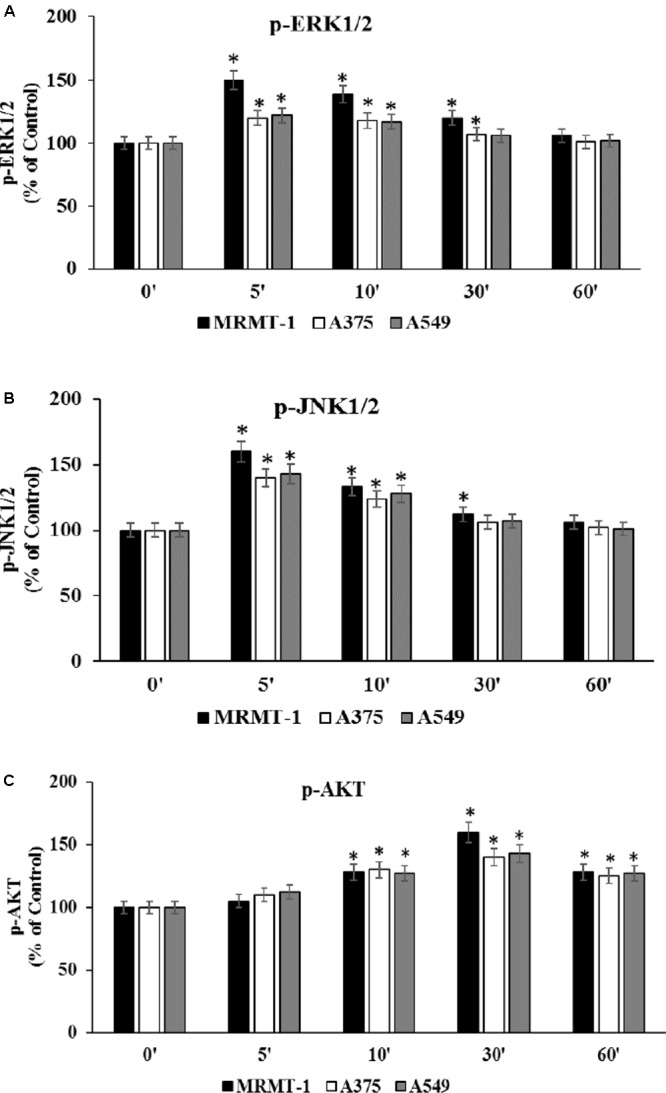
Effect of CGS 21680 on pERK1/2, pJNK1/2 MAPK kinase, and pAKT activation. Cells were incubated in the presence of 100 nM CGS 21680 for 0, 5, 10, 30, and 60 min and pERK1/2 (A), pJNK1/2 (B), and pAKT (C) protein levels were evaluated by AlphaScreen SureFire pMAPK assays in MRMT-1, A375, and A549 cells. Solutions were made up in DMSO and then diluted in cell culture medium (0.1 max 0.2% of DMSO). An equal amount of DMSO was used in control cells (CTR). ∗P < 0.01 compared with time 0. Means ± SE values from four experiments are shown. Analysis was by one-way ANOVA followed by Dunnett’s test.